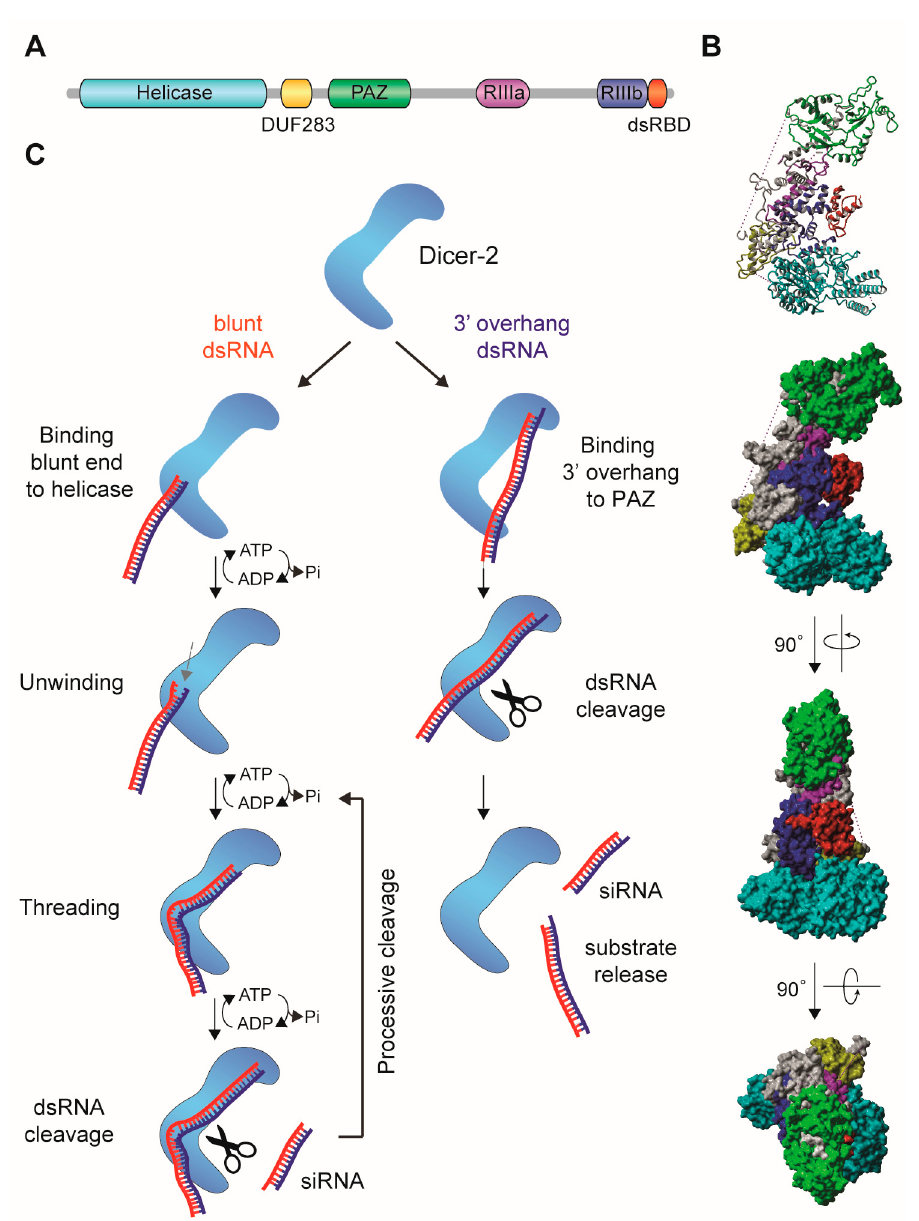
Figure 2. Dicer proteins process double-stranded RNA (dsRNA) into small interfering RNA (siRNA). ( A ) Schematic representation of the domain organization of human Dicer protein [40]. RIIIa, RNase-IIIa; RIIIb, RNase-IIIb ( B ) Cryo-EM structure of human Dicer. Protein domains are colored in accordance